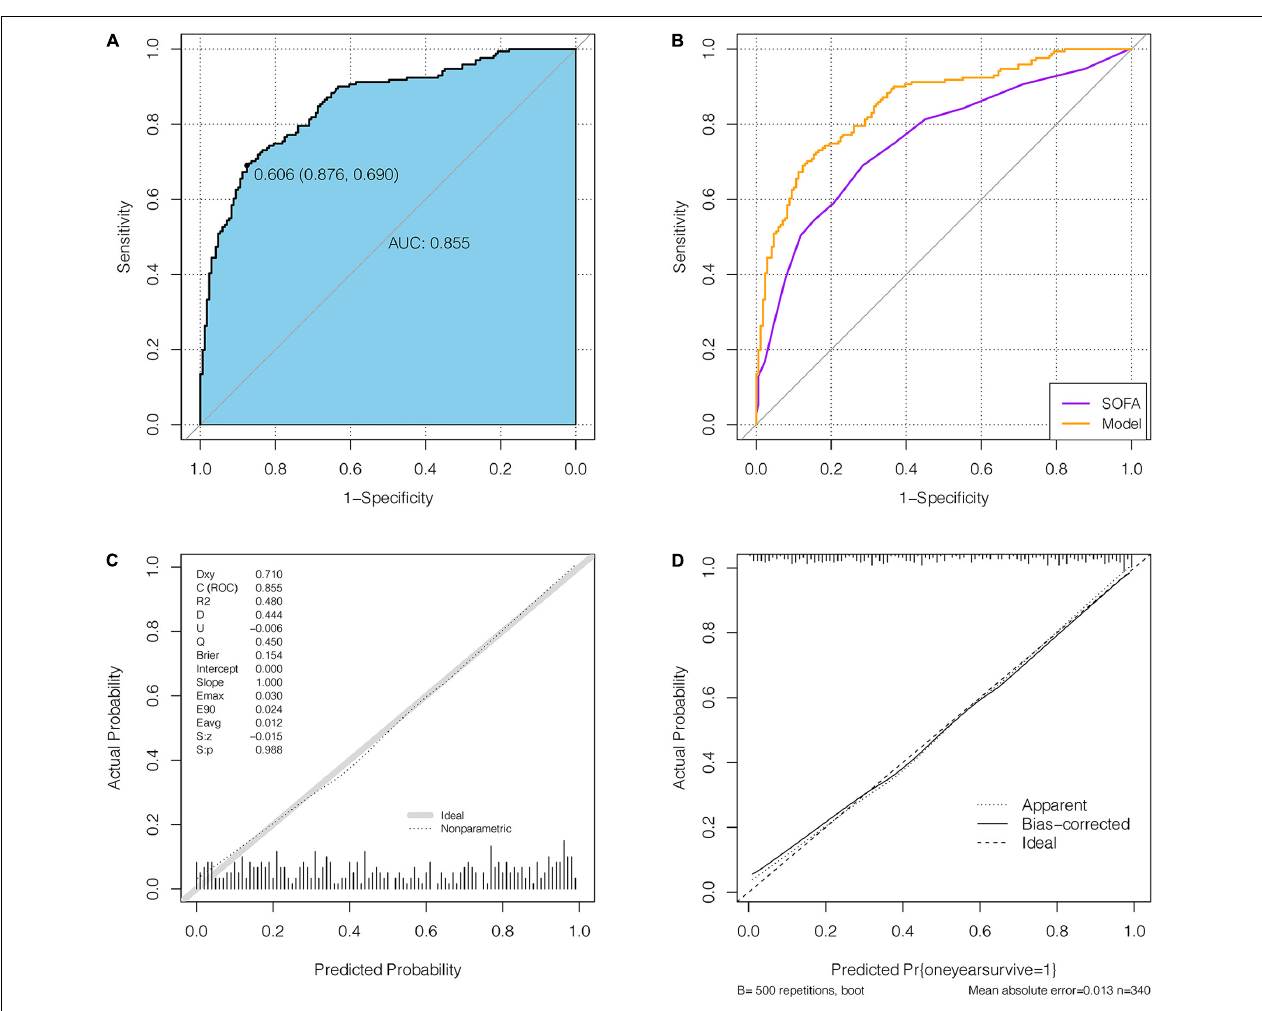
FIGURE 5 | The receiver operating characteristic (ROC) curve and calibration curve of nomogram. (A) the ROC curves of the nomogram in discovery cohort. (B) Comparison of AUC between the nomogram and SOFA. (C) The calibration curve of the nomogram. (D) Comparison of the calibration curves between the ideal model, the nomogram and the bias-corrected